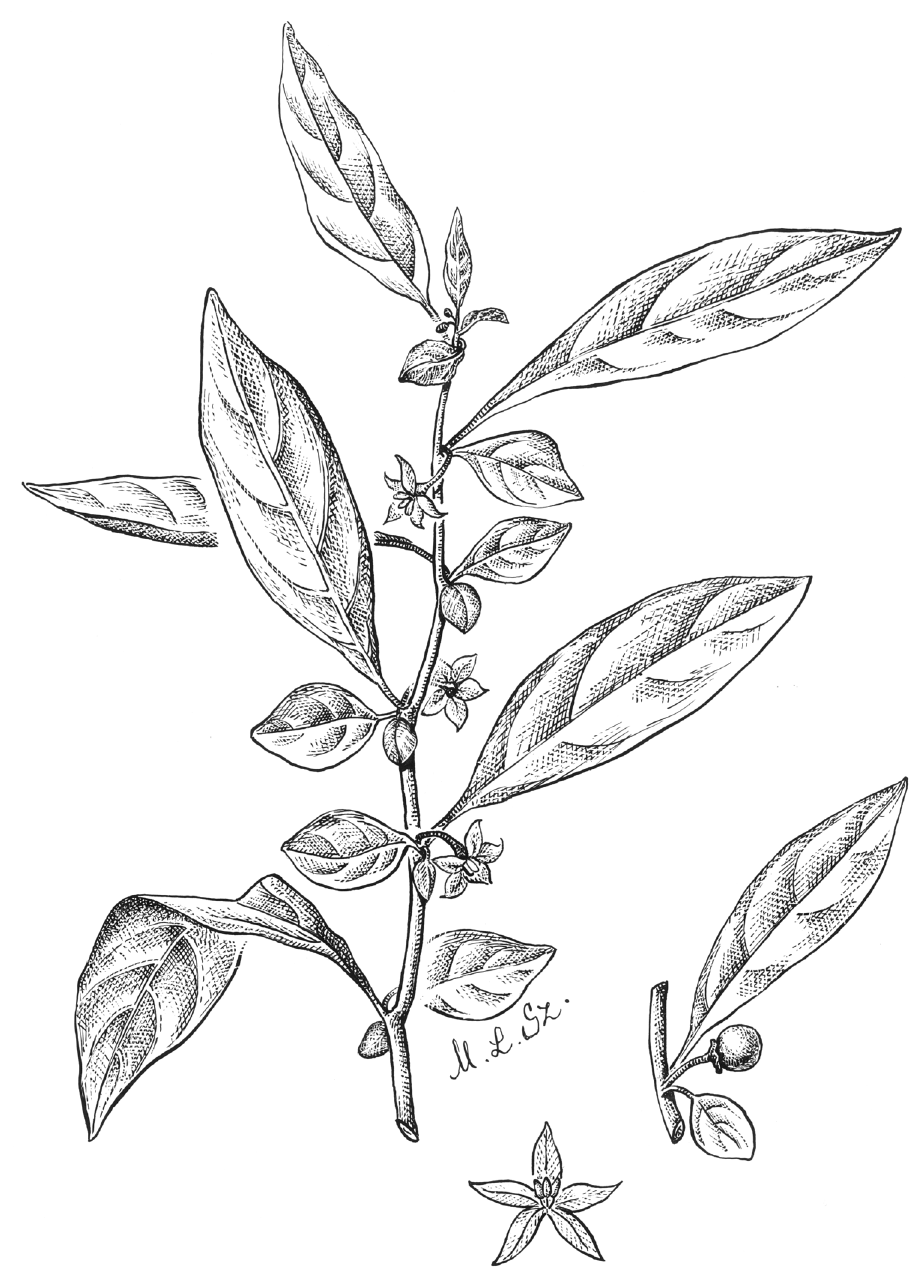
Figure 34. Lycianthes multifolia (Merr. & L.M.Perry) A.R.Bean. Drawing by M.L. Szent-Ivany, first published in Symon (1985: fig. 16, as S. multifolium Merr. & L.M.Perry). Courtesy of the Board of the Botanic Gardens and State Herbarium (Adelaide, South Australia), reproduced with